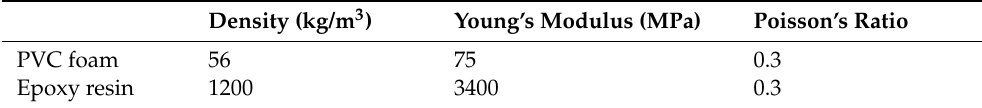
Table 2. The material properties of the used PVC foam and epoxy resin. The data were provided by the manufacturers.